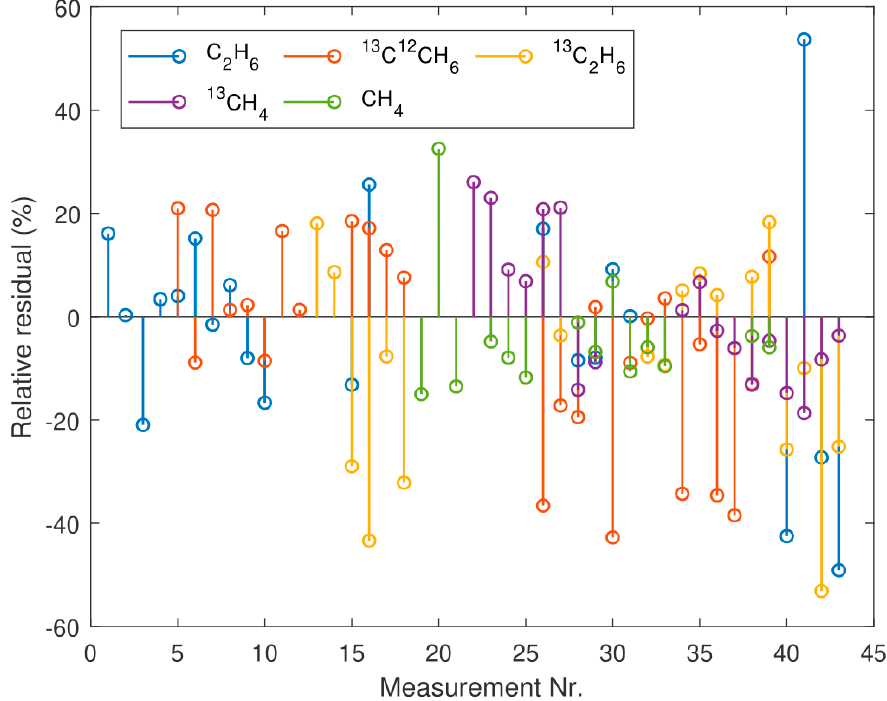
Figure A4. Cross validation relative residual of the ICL 1541 measurements.